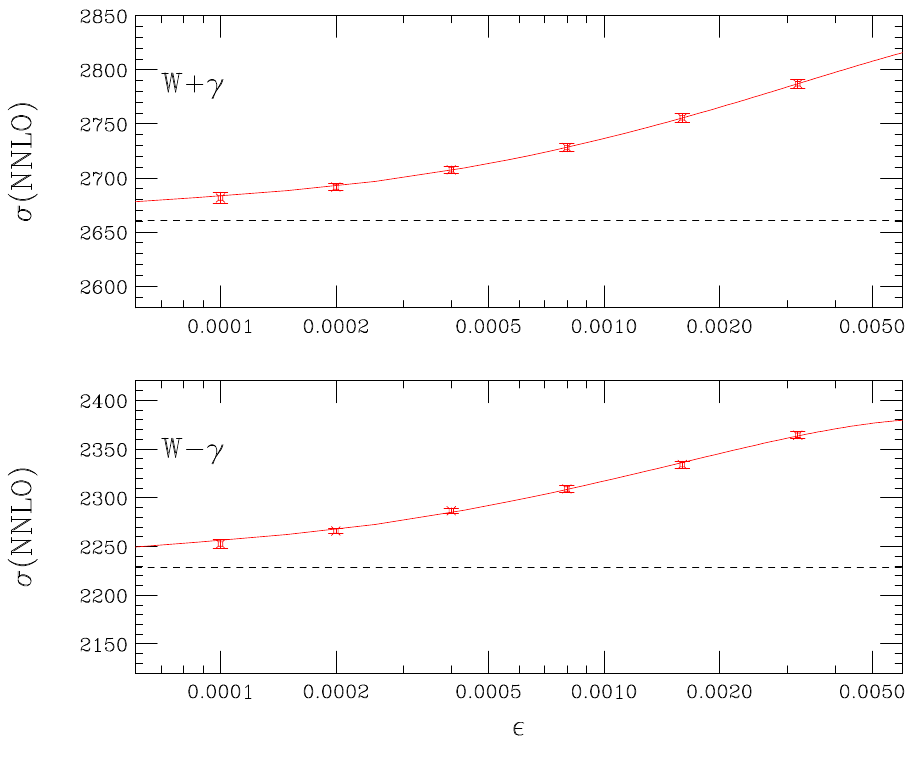
Figure 2 . τ -cut dependence of the NNLO cross sections for W + γ (upper) and W − γ (lower) production using our setup. The solid lines indicate the results of a fit to the points using the expected form of power corrections given in eq. (4.8). The asymptotic value of the NNLO cross section as (cid:15) → 0 (i.e. σ ) is indicated by the dashed 0